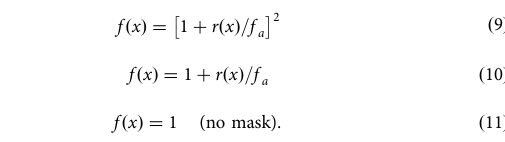
Fig. 1 for an illustration of the respective string core resolution at different times in our simulation, compared to the resolution achieved in the static lattice simulation in Gorghetto et al. 27 . Note that to match the resolution of the fi nest level on a uniform grid would require a stunning 65,536 3 cells. We use a tagging algorithm to decide on which local volumes to re fi ne, with cells tagged ensured to be within a re fi ned volume. In total we use three different tagging criteria that target (i) string cores, (ii) large gradients in ψ , and ( iii ) short wave-length radiation emitted by strings: ● String cores are identi fi ed using the procedure described in Fleury and Moore 33 (Appendix A.2). This involves fi nding plaquettes that are being pierced by strings. The cell at the low-index corner of a pierced plaquette is tagged. ● As strings decay the resulting radiation can produce large gradients in the fi eld. To ensure suf fi cient resolution we tag cells with Δ x 2 The precise numerical value is of phenomenological origin and has proven to work well in our simulation setup. ● String radiation into radial modes is highly suppressed at late times yet it can cause numerical instabilities if not suf fi ciently resolved. To avoid a numerical breakdown we tag cells at the coarse level where Δ x 0 η 3 ∇ 2 ð ψ 2 1 þ ψ 2 Þ > 4 is ful fi lled. 2